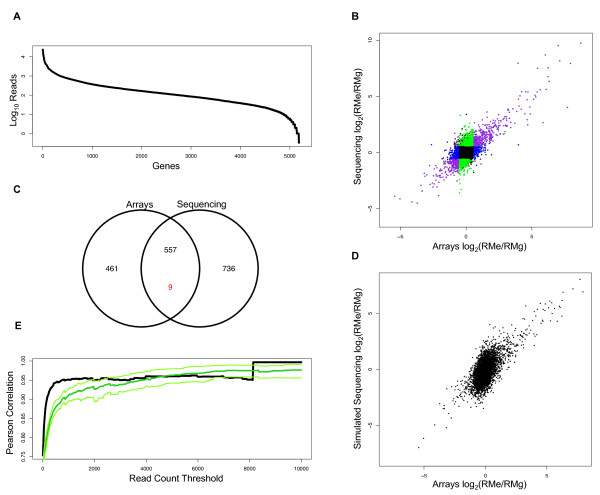
Sequencing and arrays show correlated differential expression but sequencing is more susceptible to sampling error. Read counts are not evenly distributed across genes. For the RMg sample, log10 read counts per gene are shown (A), with genes ordered by abundance. The log2 ratio of the medians of six replicate microarray experiments for RM in ethanol vs RM in glucose is compared to the log2 ratio of sequencing read counts. The methods are correlated (R = 0.75356, 95% CI: 0.7236–0.785). Colors indicate significantly differentially expressed genes at a FDR<1% and 1.5 fold or greater change, where significance is determined using Fisher's exact test for the sequencing data and the Mann-Whitney test for the array data. Purple indicates significantly different by both methods, green is significantly different by sequencing only, blue is significantly different by microarrays only, and red is significant by both methods but with opposite directionality (B). Data from (B) but represented as a Venn diagram of significant differences; note in red the 9 genes measured as significantly changed but in opposite directions (C). The results from (B) can be modeled by sampling from binomial distributions for each gene. Here a single random sampling is shown (D). The correlation of log2 expression ratios determined by microarrays and sequencing is highly dependent on the number of read counts per gene. For both the actual data (black), and simulated data (green) with 95% confidence intervals (light green), correlation improves as the thresholds for sequence coverage increase (E).